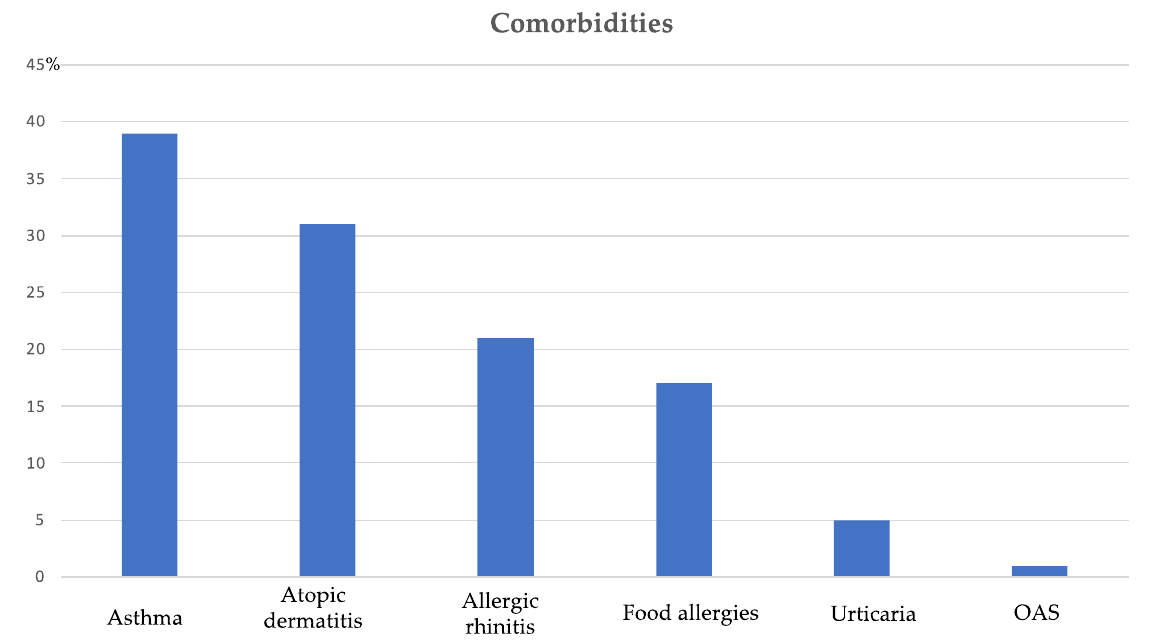
Figure 1. Comorbidities in patients performing OFC to cow’s milk.